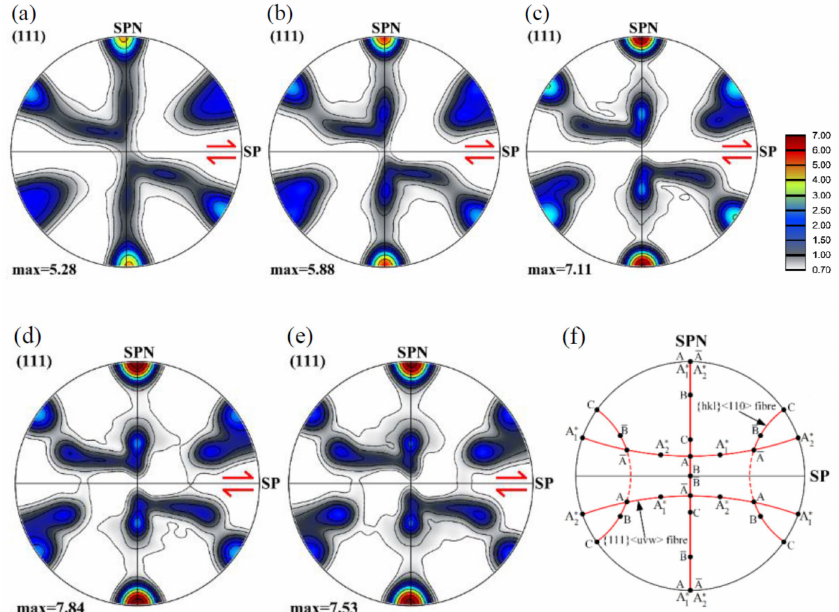
Figure 5. Texture evolution in {111} pole figures of a 3D polycrystal with random initial texture at shears of 1 ( a ), 2 ( b ), 4 ( c ), 6 ( d ), and 8 ( e ), and the ideal orientations of face-centered cubic (FCC) shear textures in {111} pole figure ( f ). (SP indicates the shear plane, and the arrow is orientated in the shear direction; SPN is the shear plane